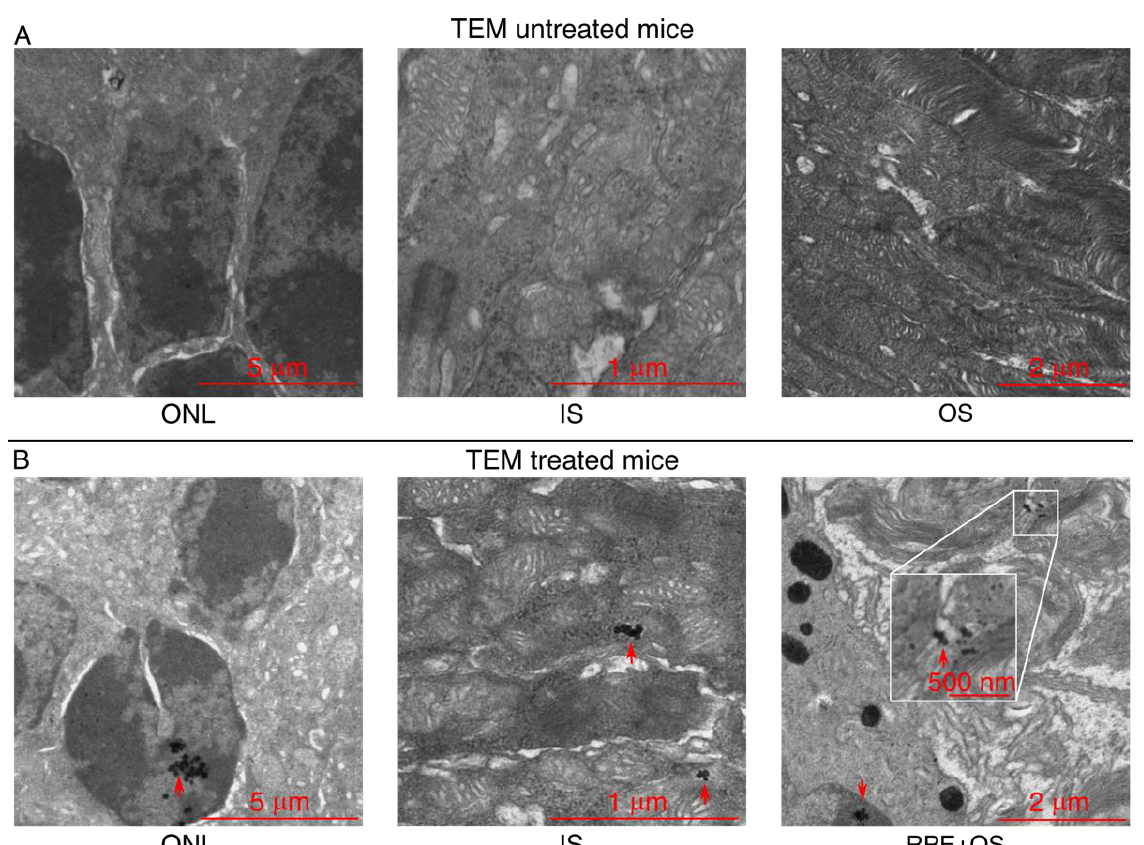
Figure 4. MNPs localize in the retina of Bbs +/+ mice after their topical administration. ( A ) TEM images showing the different layers of the retina of untreated Bbs +/+ mice, and ( B ) the presence of the MNPs in the retina of treated Bbs +/+ mice. The red arrows indicate the MNPs’ localization.